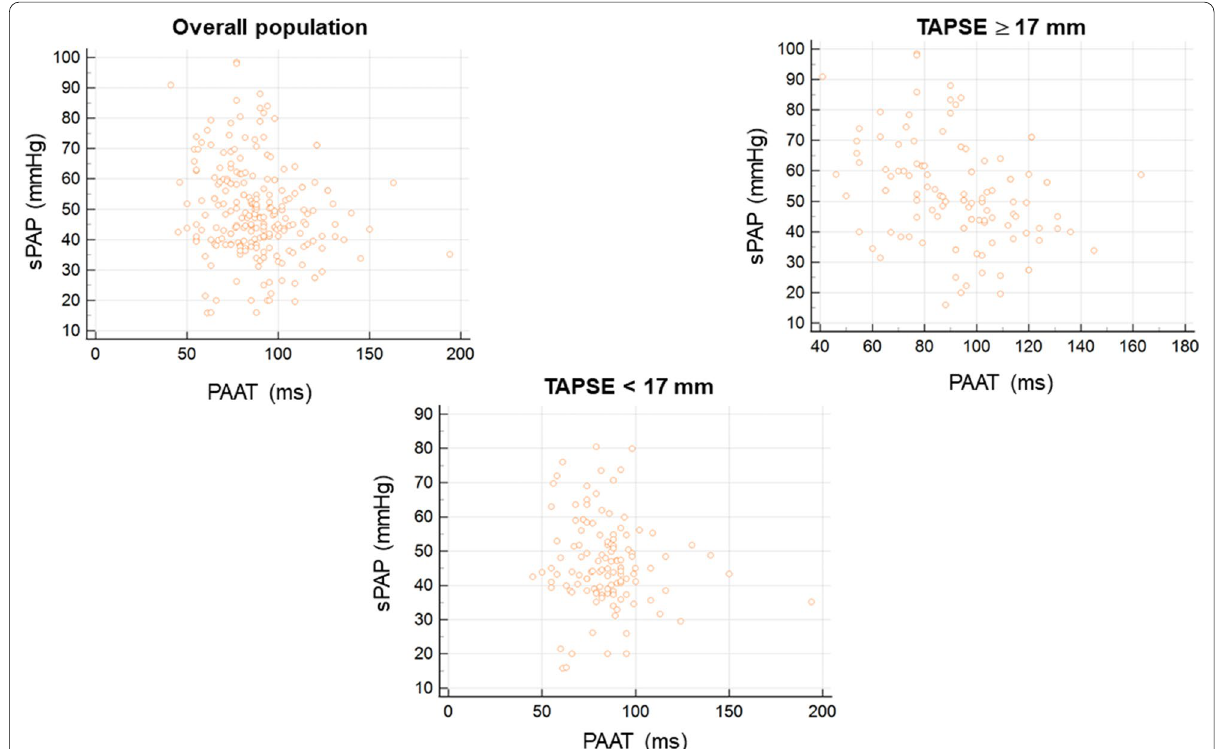
Fig. 2 Scatter plot diagrams showing relationship between TR-derived sPAP and PAAT in overall population (left upper panel), preserved RV systolic function (right upper panel) and RV systolic dysfunction (lower panel)